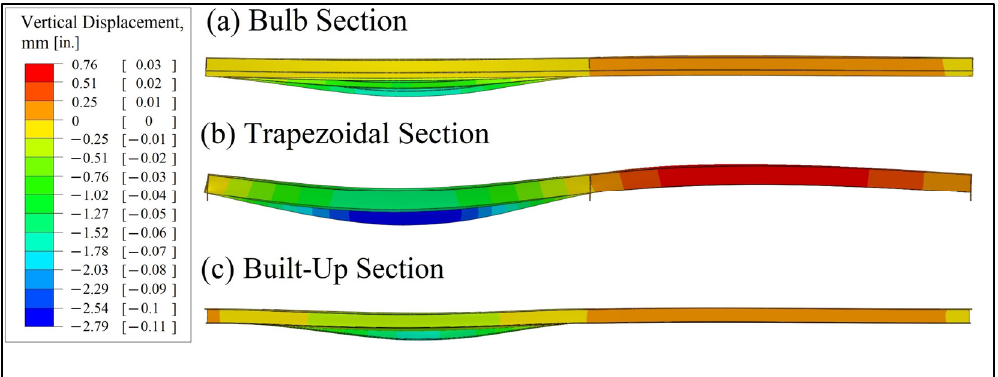
Figure 20. Continuum case 3 scaled deflection shapes.